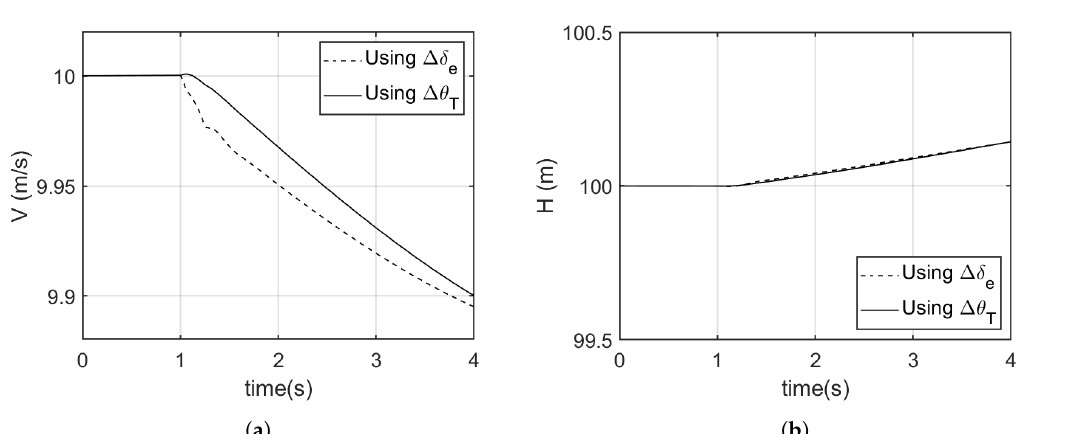
Figure 12. Model 2 aircraft pull up maneuver time response. ( a ) Airspeed. ( b ) Height.